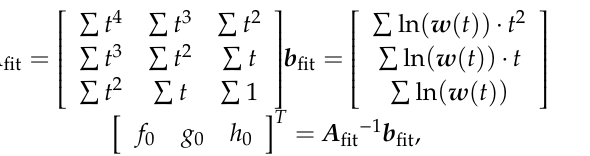
Figure 10. Water column scattering model.